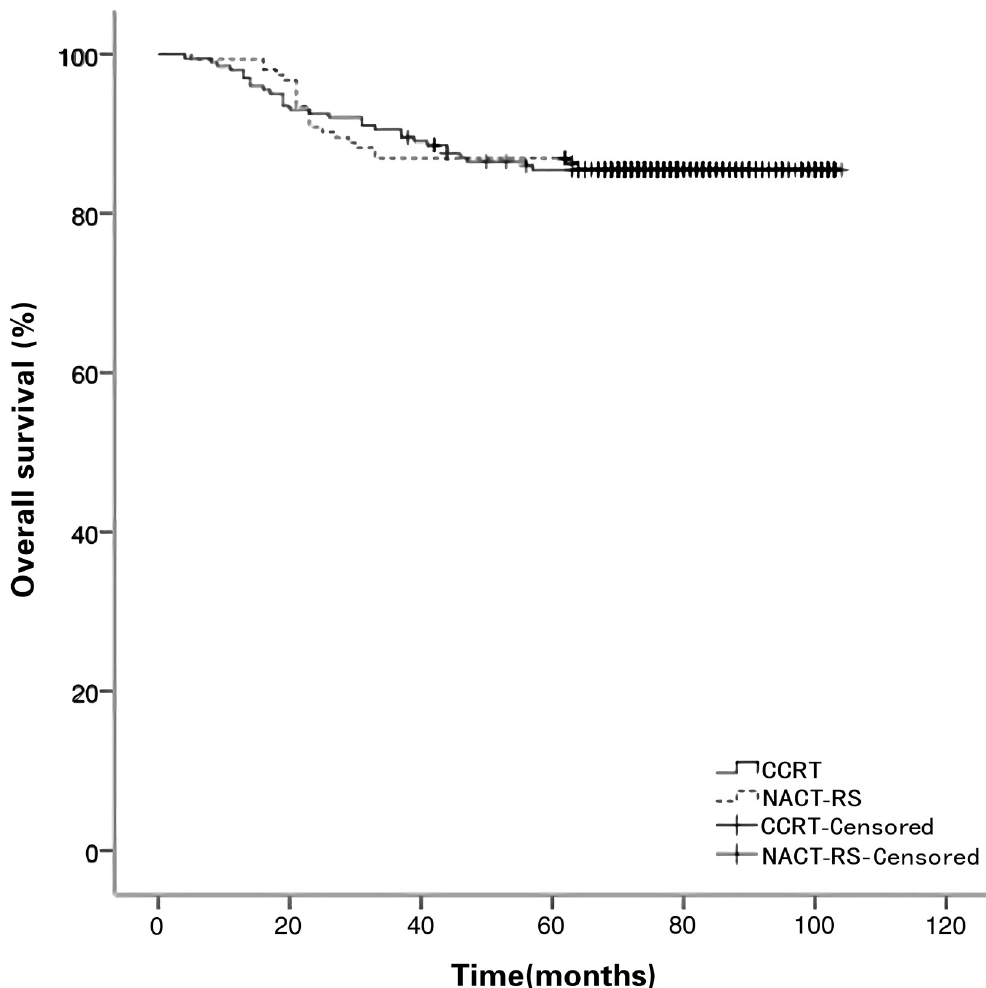
Fig 2. Overall survival curves for patients in the NACT-RS and CCRT groups. CCRT, concomitant chemotherapy, and radiotherapy; NACT-RS, neoadjuvant chemotherapy followed by radical